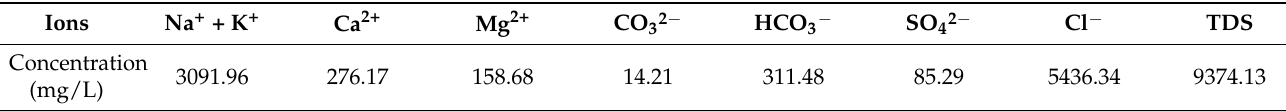
Table 2. Ion components of simulated formation water in Bohai oil